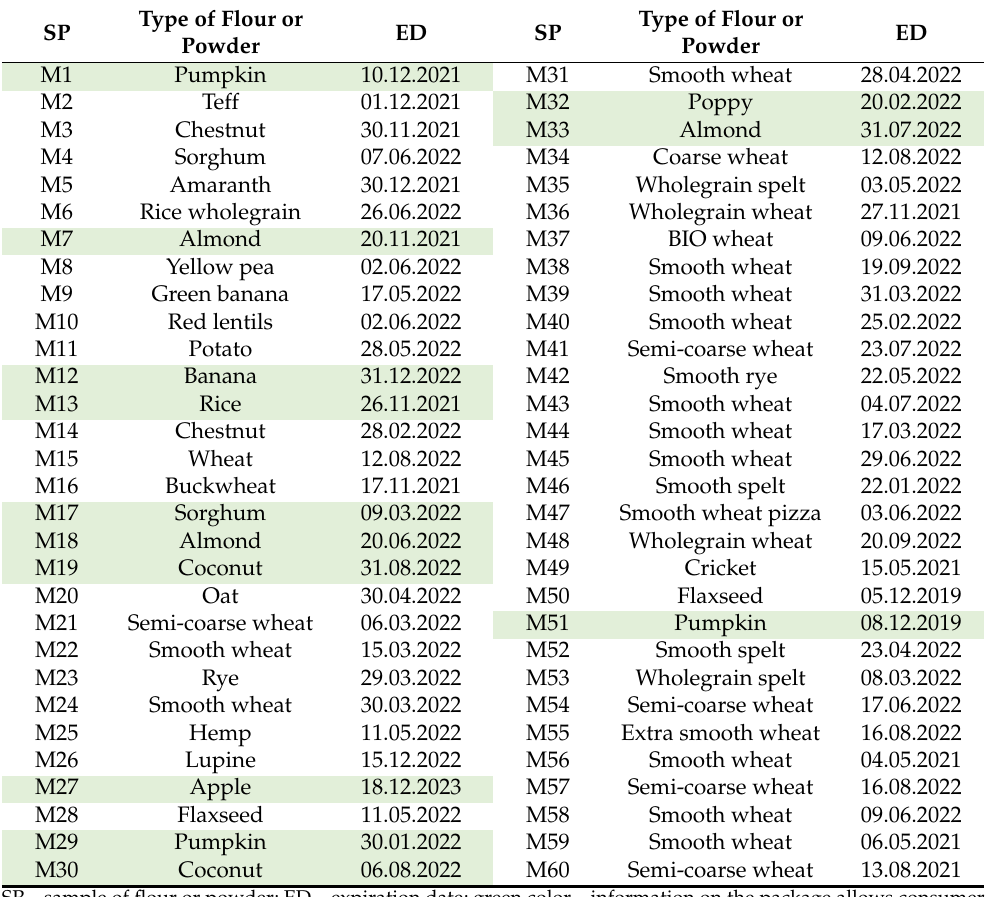
Table 1. Details and types of flours and powders subjected for microbial analyses.